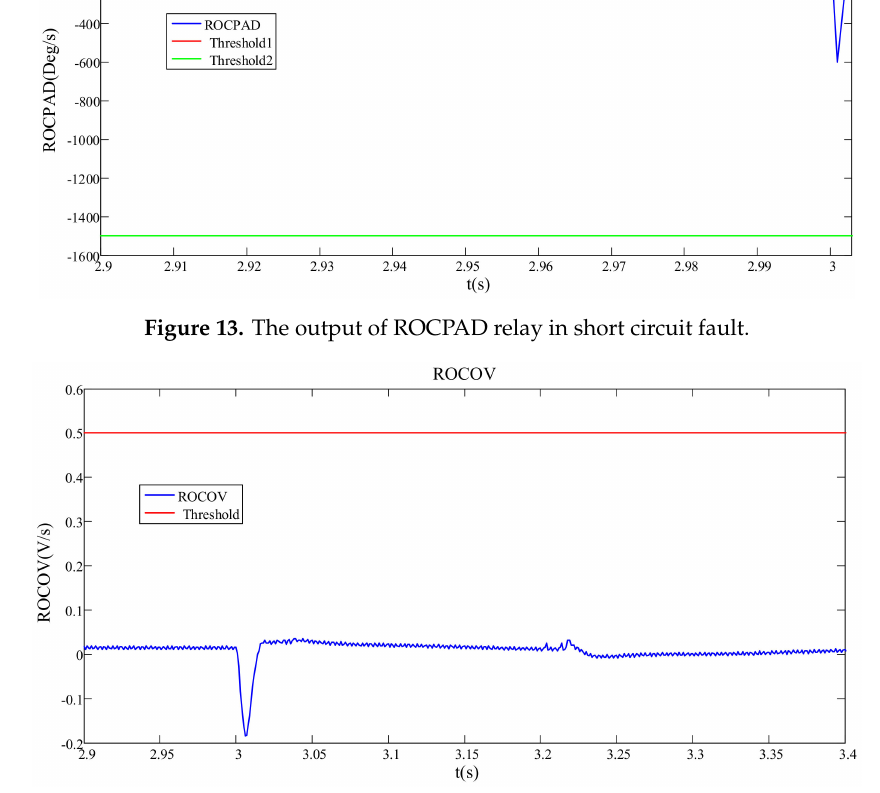
Figure 14. The output of ROCOV relay in short circuit